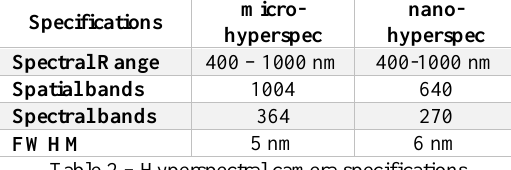
Figure 4 – Airframe speed plotted for a one pass, allowing stable section of flight to be